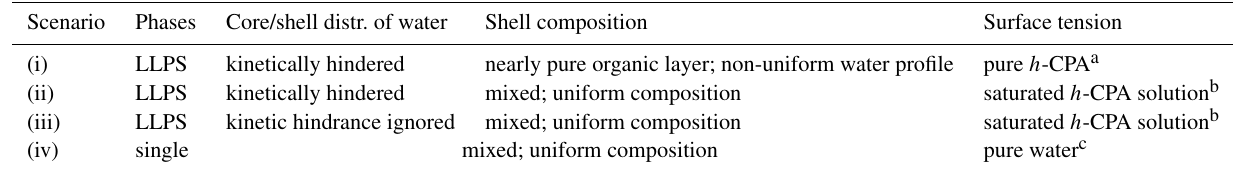
Table 1. Scenarios for Köhler theory calculations.